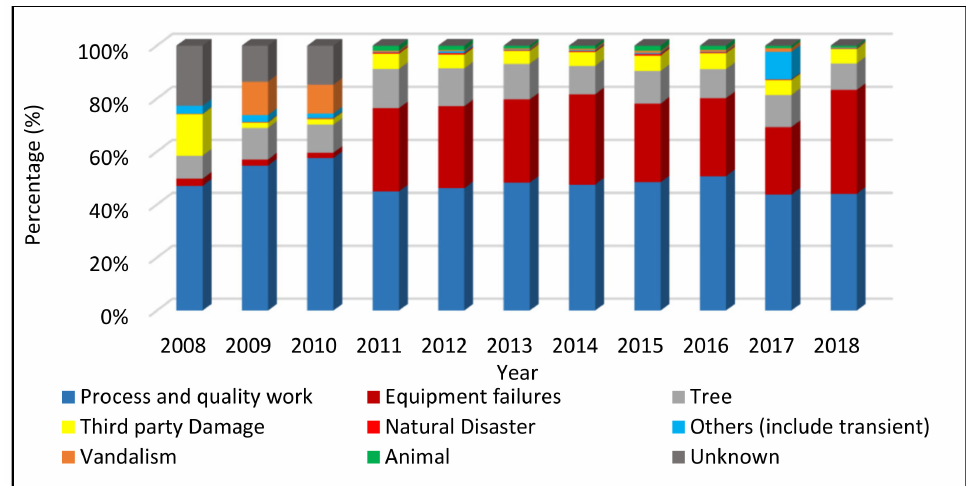
Figure 4. Bar chart of fault causes interruptions in Peninsular Malaysia from 2008 to 2018 [50–60].